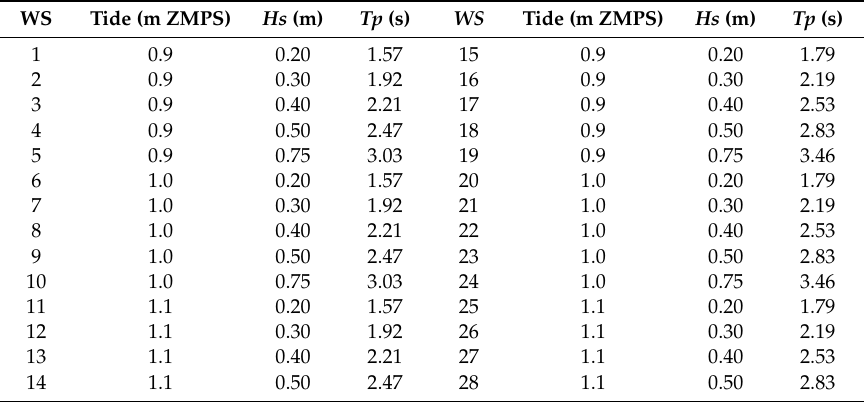
Figure 7. Front view of two tested types of cross-section: vertical wall type B ( a ), and wall with steps type C ( b ). Table 2. Test programme repeated for each tested